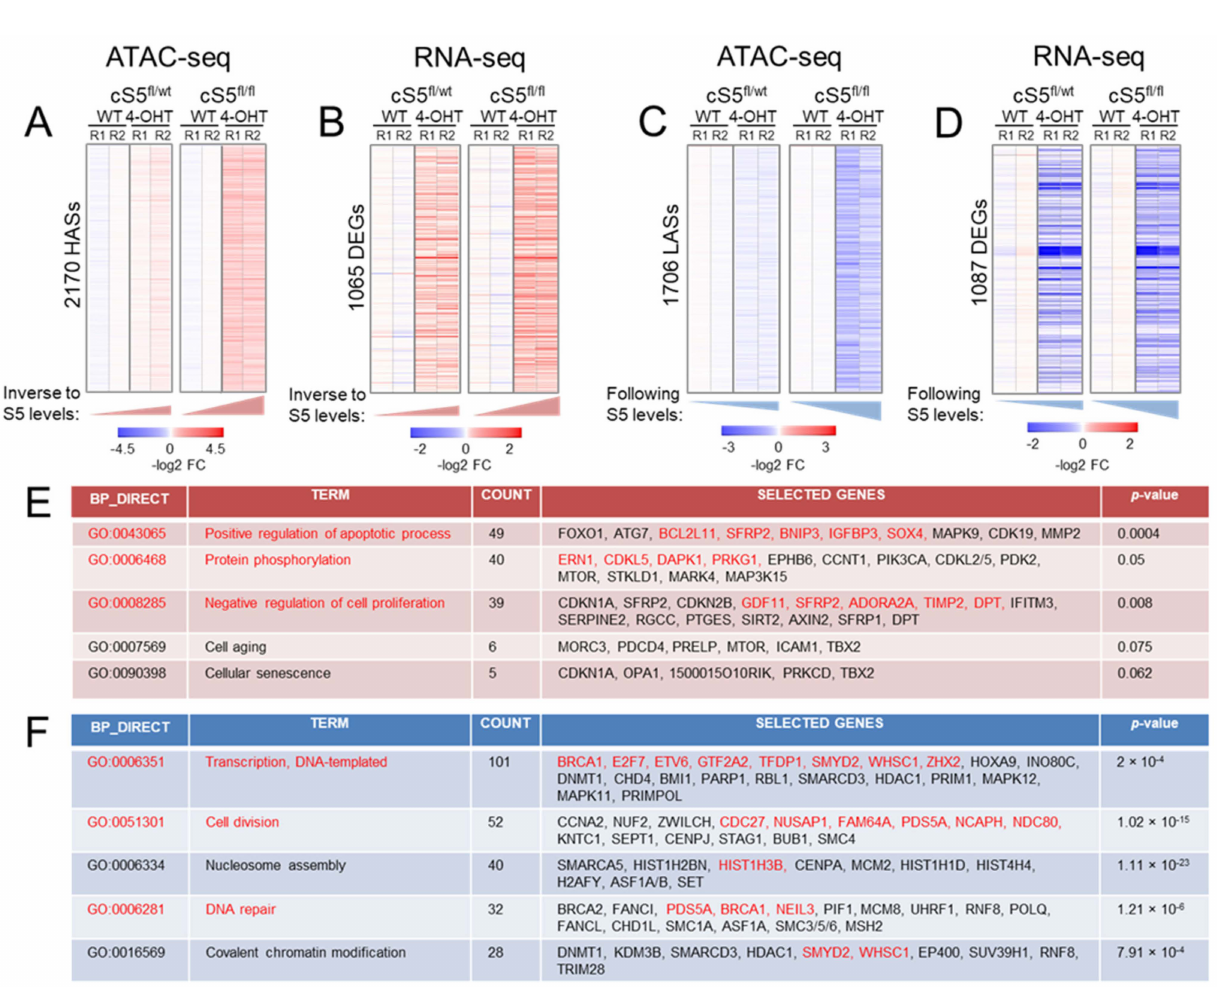
Figure 2. Epigenomic and transcriptomic remodeling upon the gradual loss of Smarca5. ( A ) Heatmap showing differentially accessible ATAC peaks displaying higher accessibility in the knockout cells, p -value–0.025. Notice the gradual increase in accessibility from the single allele knockout (cS5 fl/wt , 4-OHT) to the double allele knockout (cS5 fl/fl , 4-OHT) compared to their respective wildtypes (WT), HASs = higher accessibility sites. ( B ) Heatmap showing gradually upregulated genes from single to double-allele knockout MEFs, p -value–0.05. DEGs = differentially expressed genes. Notice the gradual increase in gene expression from cS5 fl/wt , 4-OHT to the cS5 fl/fl , 4-OHT compared to their respective wildtypes. ( C ) Heatmap showing differentially accessible ATAC peaks displaying lower accessibility in the knockout cells, p -value–0.025. Notice the gradual decrease in accessibility from the single allele knockout to the double allele knockout. LASs = lower accessibility regions. ( D ) Heatmap showing the gradually downregulated genes in the knockout cells, p -value–0.05. ( E ) Gene Ontology pathways (GO) in upregulated genes as interrogated by DAVID. Text in red shows events (pathways/genes) common in both chromatin accessibility and gene expression dataset as inspected by ATAC-seq and RNA-seq. ( F ) GO pathways in downregulated genes as interrogated by the DAVID tool (human orthologue gene symbols are shown as a default output of DAVID). Text in red font shows events (pathways/genes) common to both chromatin accessibility and gene expression datasets. WT = cells untreated with 4-OHT; log2 FC–log2-transformed fold-change from the WT baseline condition; R1, R2 = experimental replicates 1 and